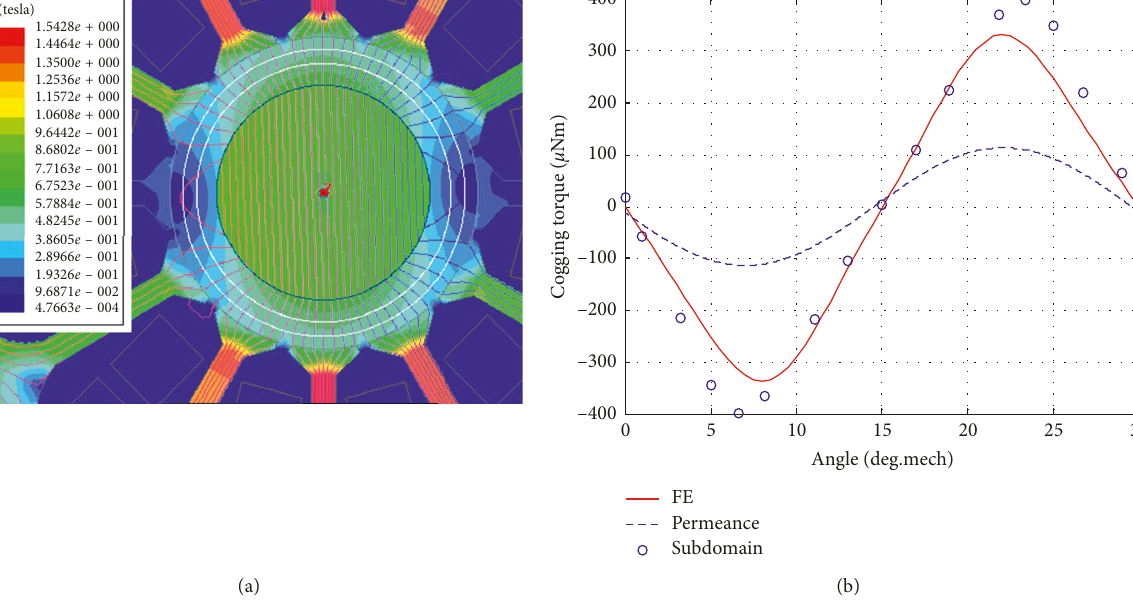
Figure 5: PM field and cogging torque. (a) PM field. (b) Comparison of the cogging torque of FEM and the analytical